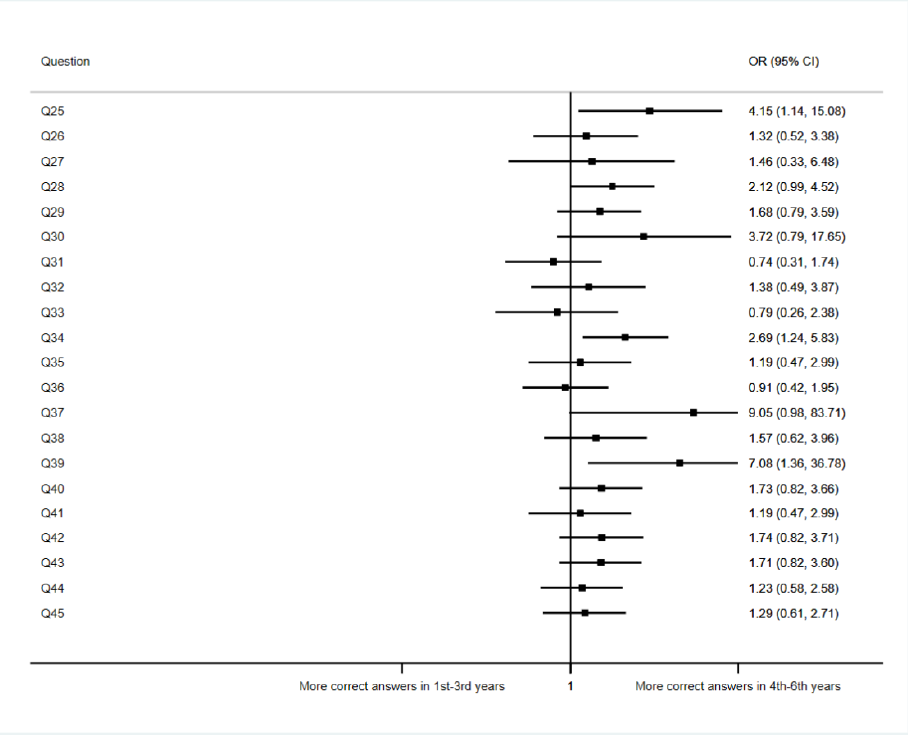
Figure 3. Association between questions regarding students’ opinions and academic year ( ref. 1st –